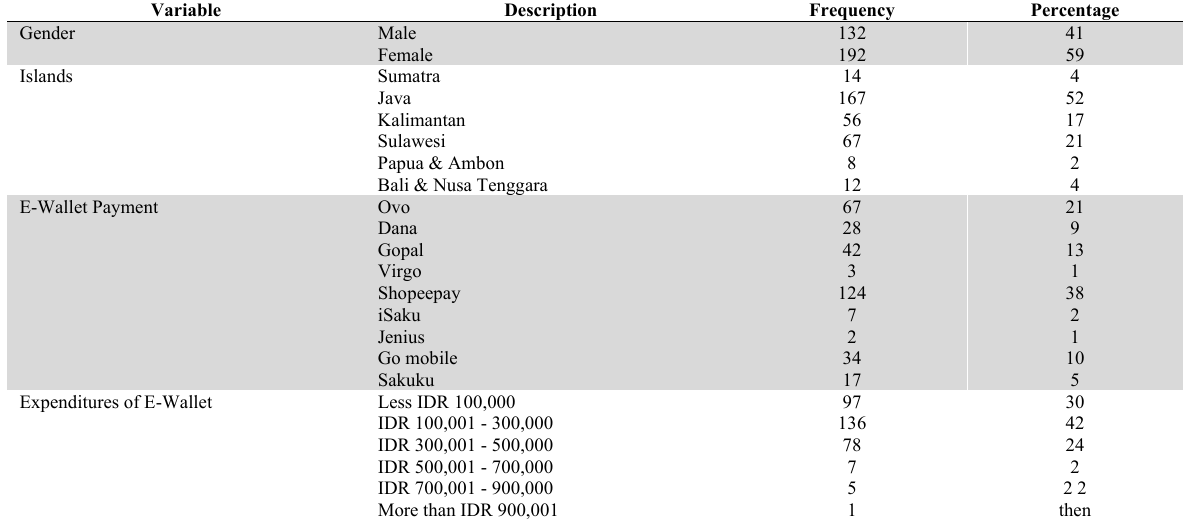
Characteristics of Research